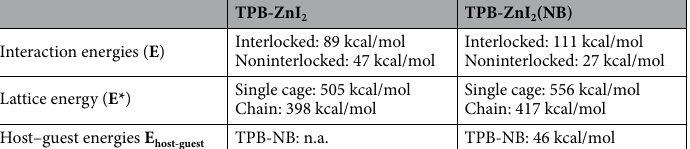
TPB-ZnI 2 TPB-ZnI 2 (NB) Interaction energies ( E